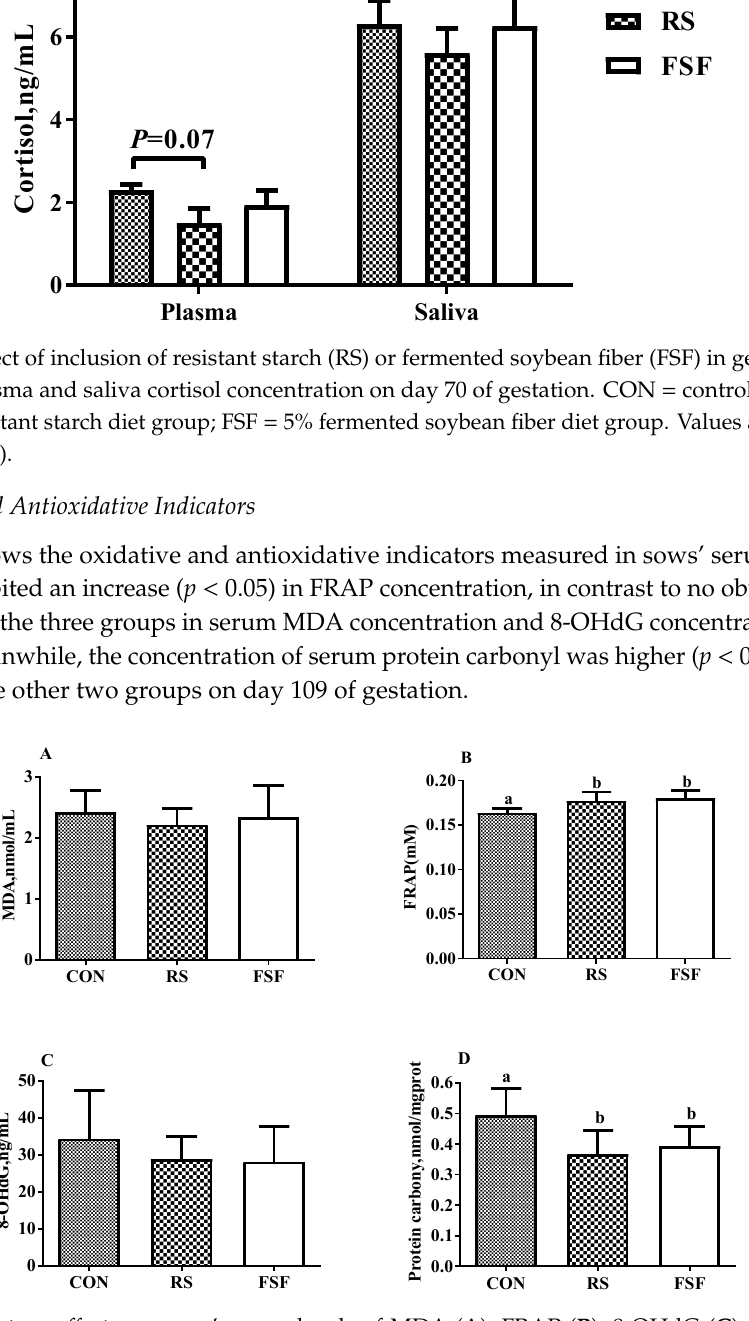
Figure 4. Dietary e ff ects on sows’ serum levels of MDA ( A ), FRAP ( B ), 8-OHdG ( C ) and protein carbonyl ( D ) on day 109 of gestation. MDA = Malondialdehyde; 8-OHdG = 8-hydroxy-deoxyguanosine; FRAP = Ferric ion reducing antioxidant power. CON = control diet group; RS = 5% resistant starch diet group; FSF = 5% fermented soybean fiber diet group. Values are means ± SEM ( n = 8). a,b Means with di ff erent superscript letters within a row di ff er significantly ( p <